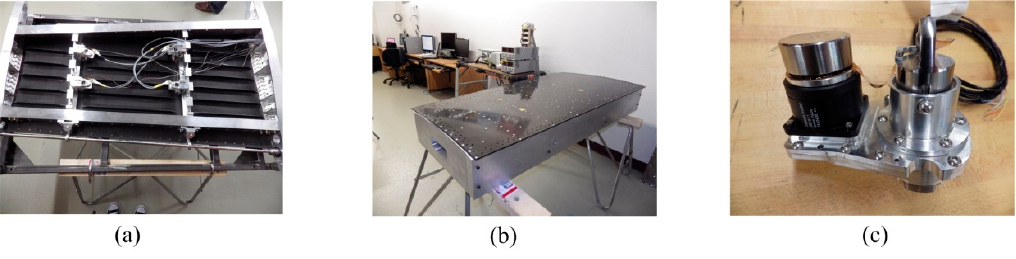
Figure 1. Morphing wing and Brushless DC (BLDC) motor-based actuator.